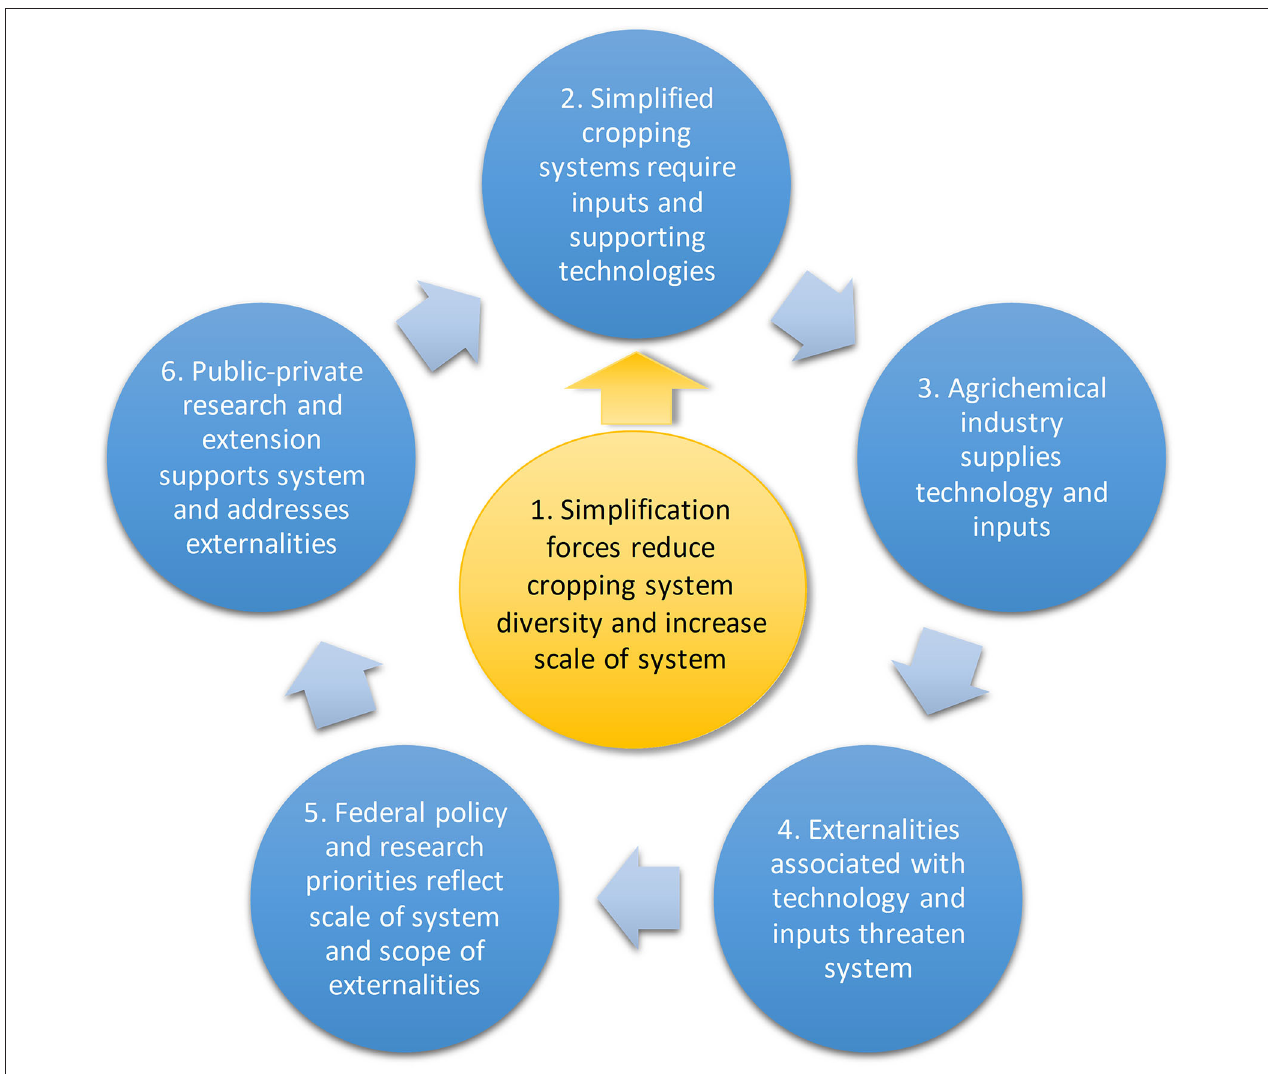
FIGURE 3 | The crux of the cropping system diversification problem: feedbacks that reinforce cropping system simplification. We argue that steps 5 and 6 are where efforts could be made to break the cycle of simplification and encourage cropping system diversification at larger